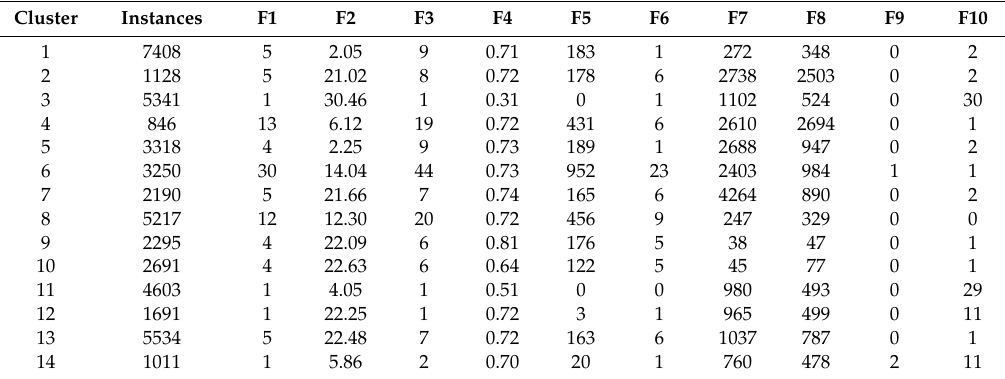
Table 5. The average characteristic values and results of k-means